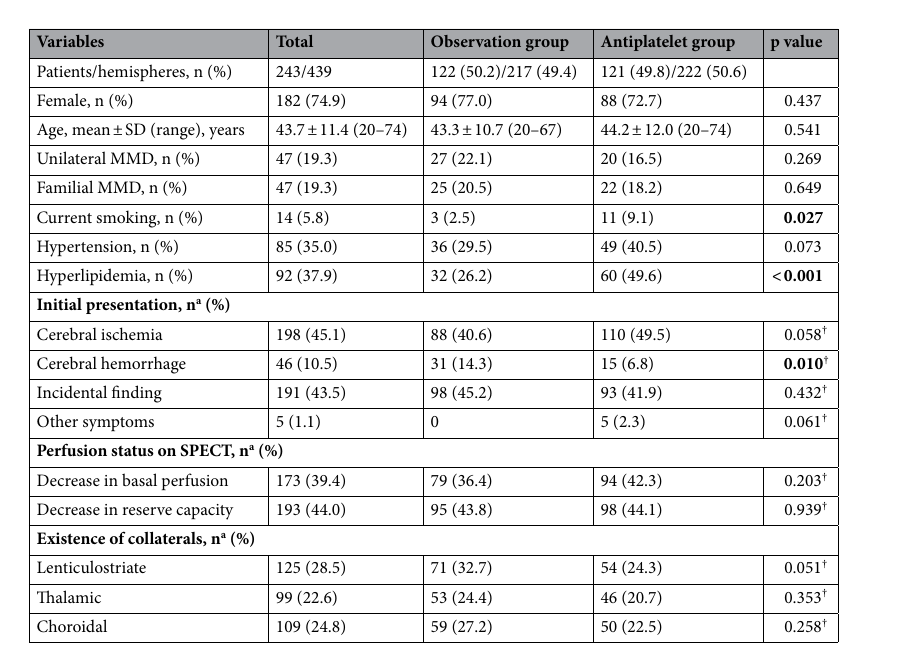
Figure 1. Flow chart of the patient selection. MMD moyamoya disease.